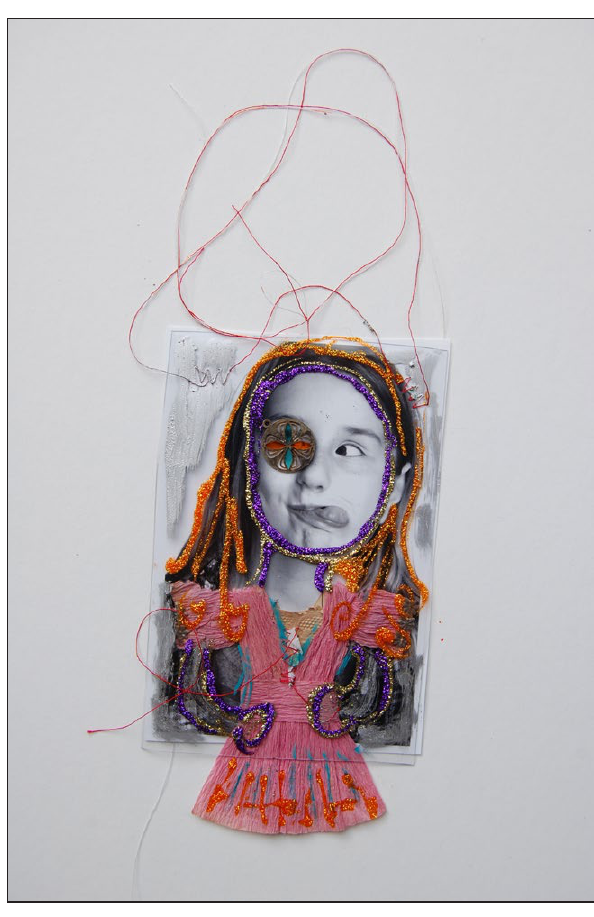
Figure 7: Brain Candy: Sassafras,